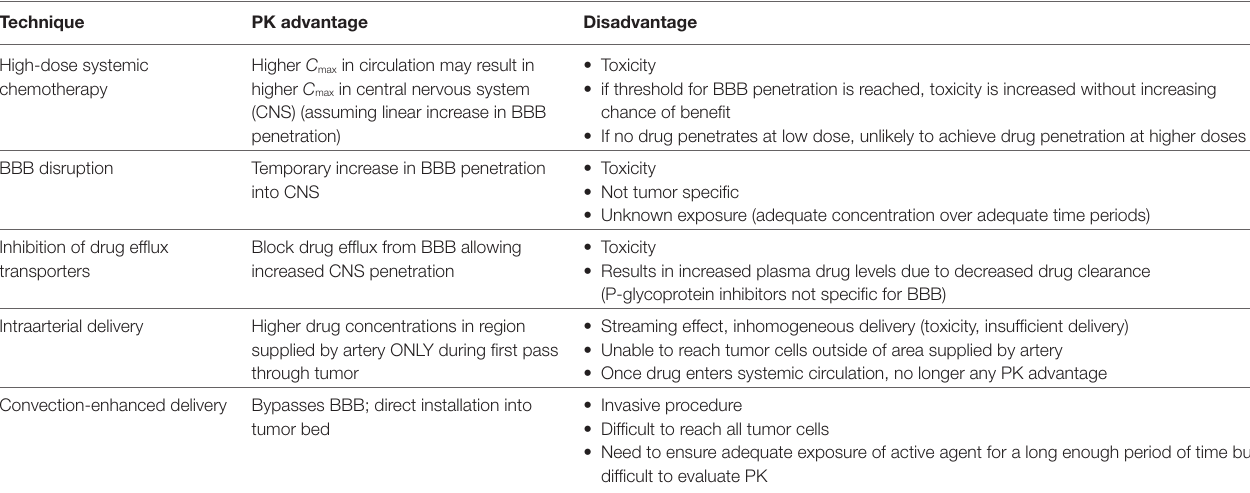
TaBle 3 | Techniques to overcome the blood:brain barrier (BBB).